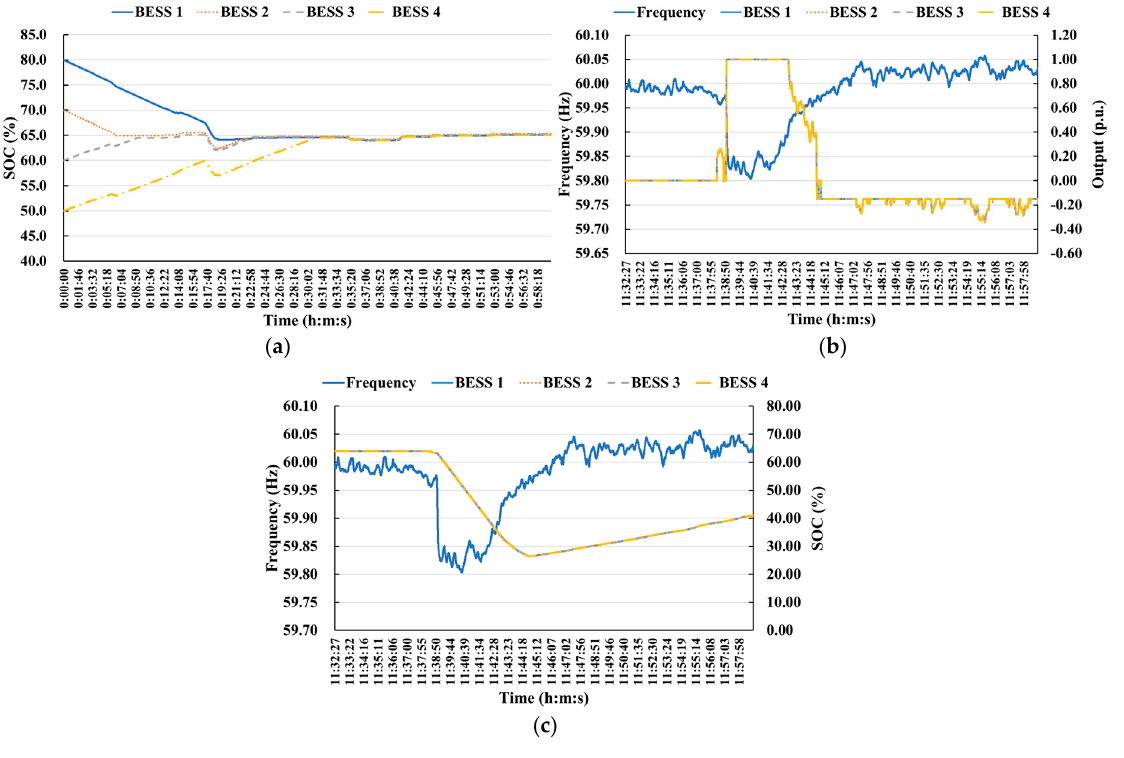
Figure 12. Details of the simulation result: ( a ) synchronized SOC result from each BESS; ( b ) output of